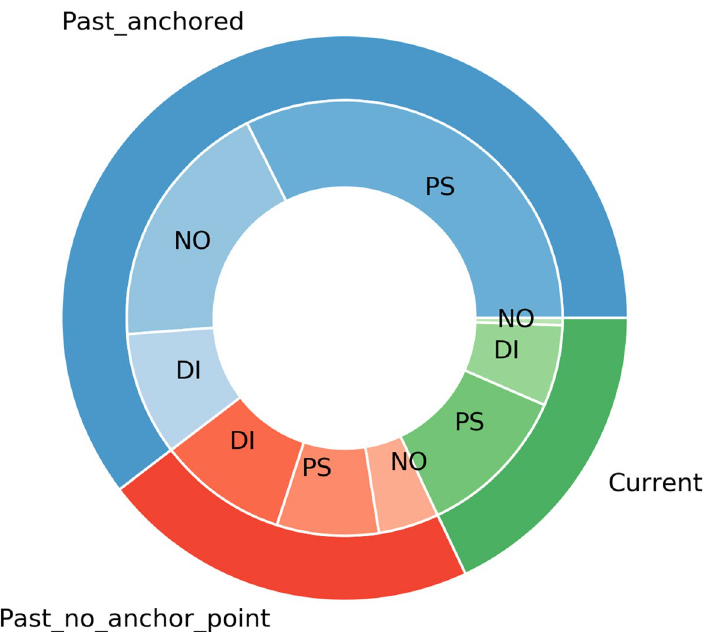
Figure 4. Distribution of the Type attribute in relation to Time_information (adjudicated dataset). PS psychosis symptom; DI diagnosis; NO non-specific. Past_anchored annotations (60%) were mostly related to symptoms (54%) and non-specific instances (31%). Past_not_anchored annotations (22%) had a higher number of diagnoses